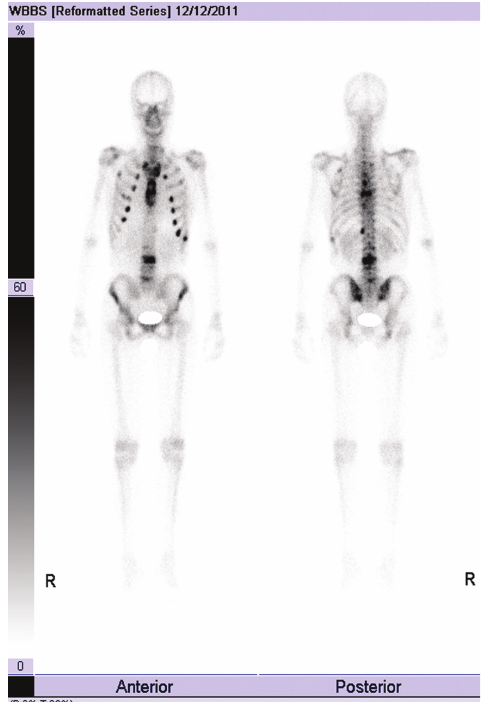
Figure 5: Tc-99m MDP WBBS before chemotherapy found a wide range of abnormal radioactive accumulation in ribs, thoracic and lumbar vertebra, sacrum, and